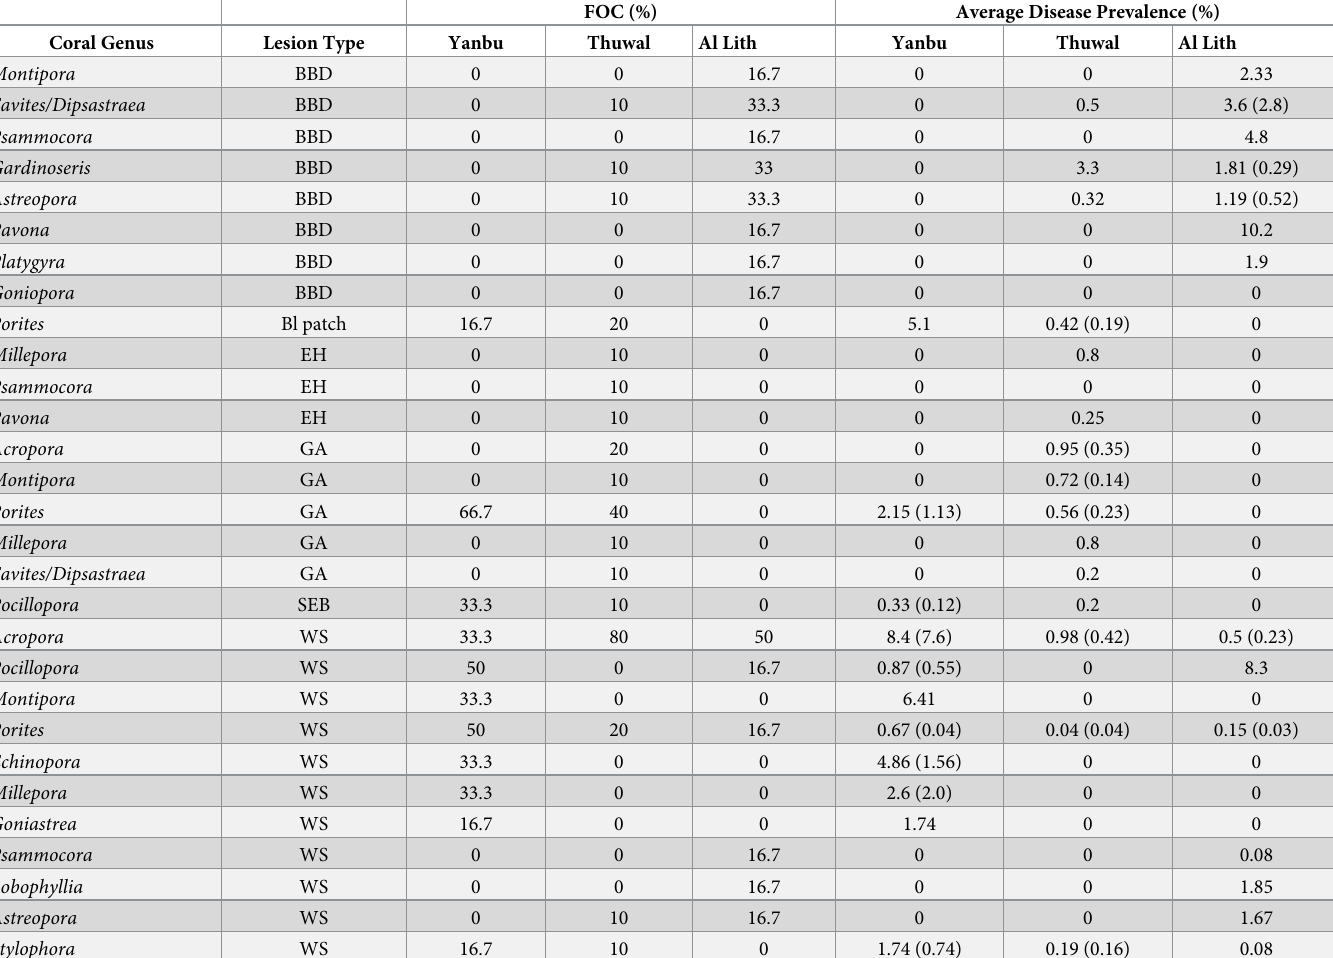
Table 3. Regional differences in frequency of occurrence (FOC) and average prevalence ( ± SEM) of different coral diseases found during surveys in the central Red